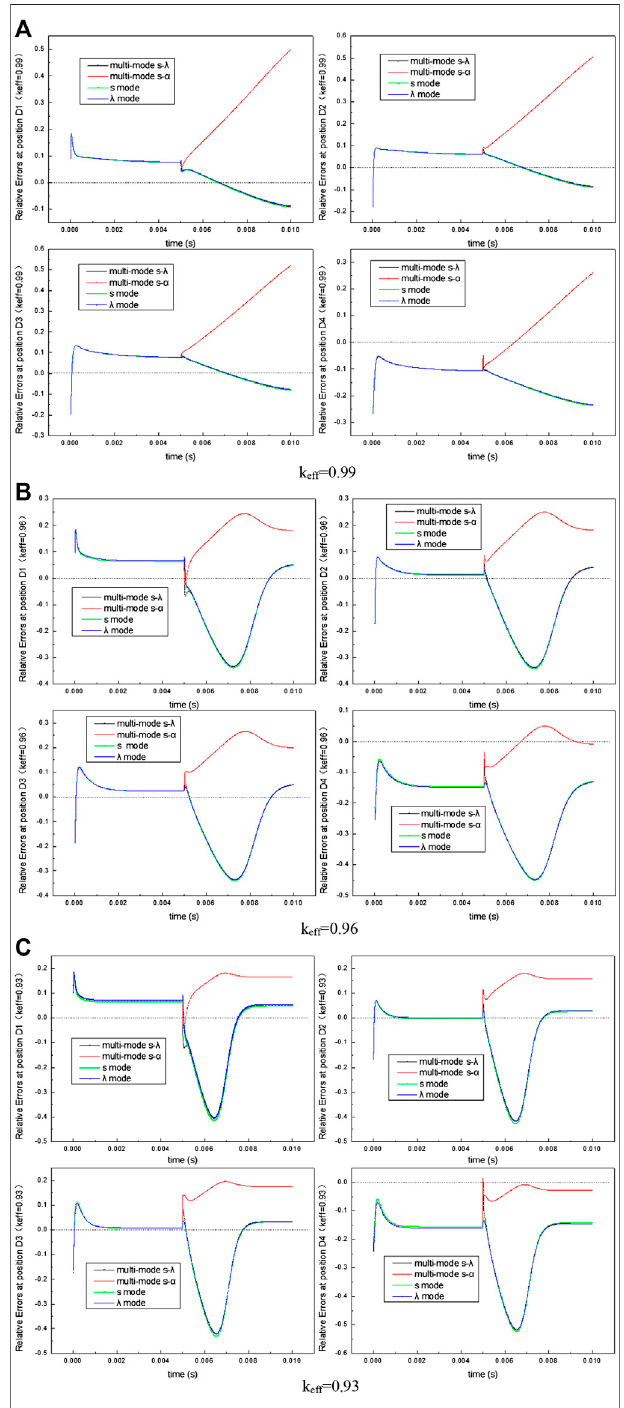
FIGURE 4 | Relative errors for the results of neutron kinetics at different positions under various sub-criticalities and beam transient conditions.